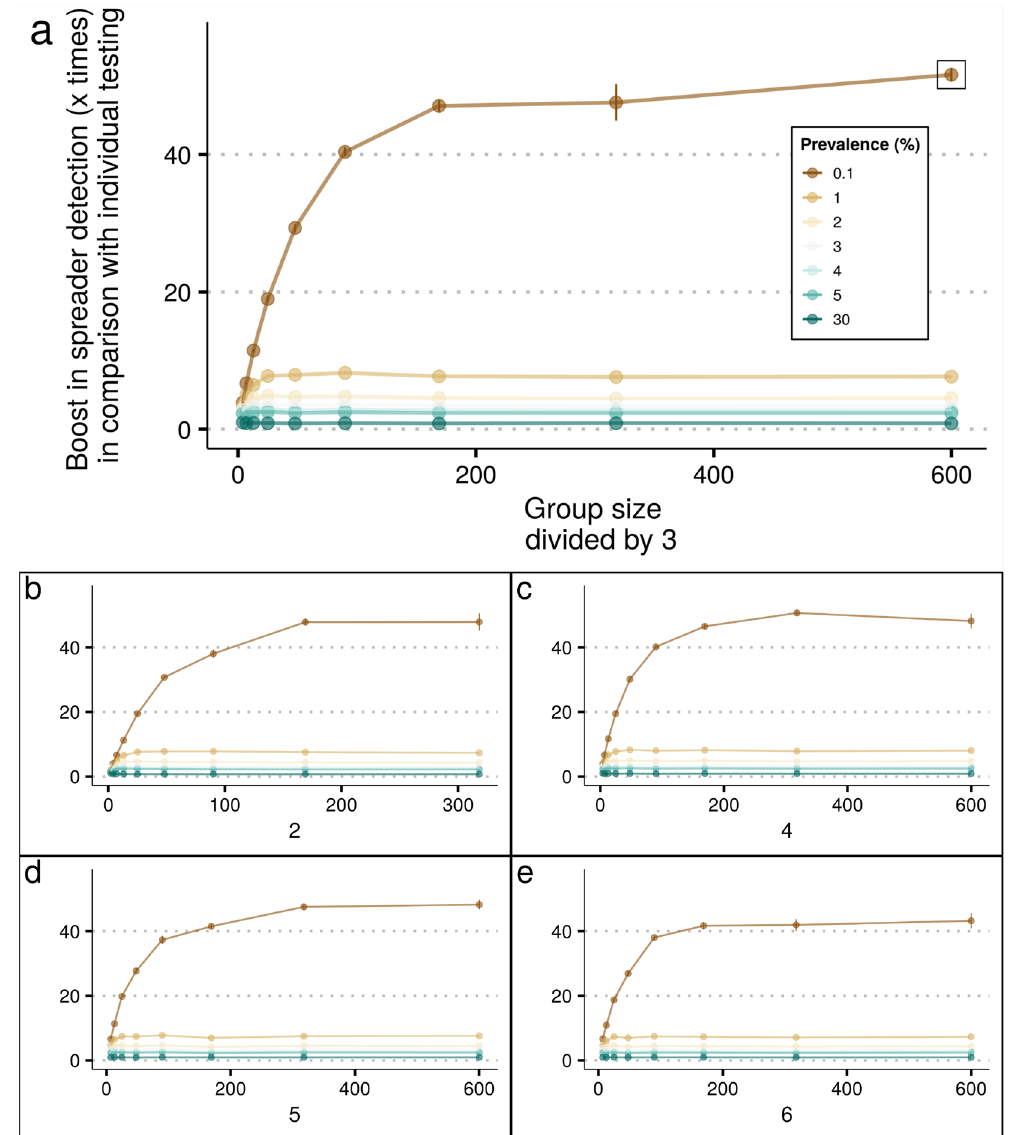
Figure 4. The boost in screening power by the use of multi-stage testing configurations. Each plot shows the boost among different denominators (i.e. the way the master group is divided). ( a ) The denominator with the multi-stage OTC for 0.1% of prevalence for which the master group is subsequently divided by three. The OTC is highlighted by a square around the point. ( b ) Master group divided by two. ( c ) Master group divided by four. ( d ) Master group divided by five. ( e ) Master group divided by